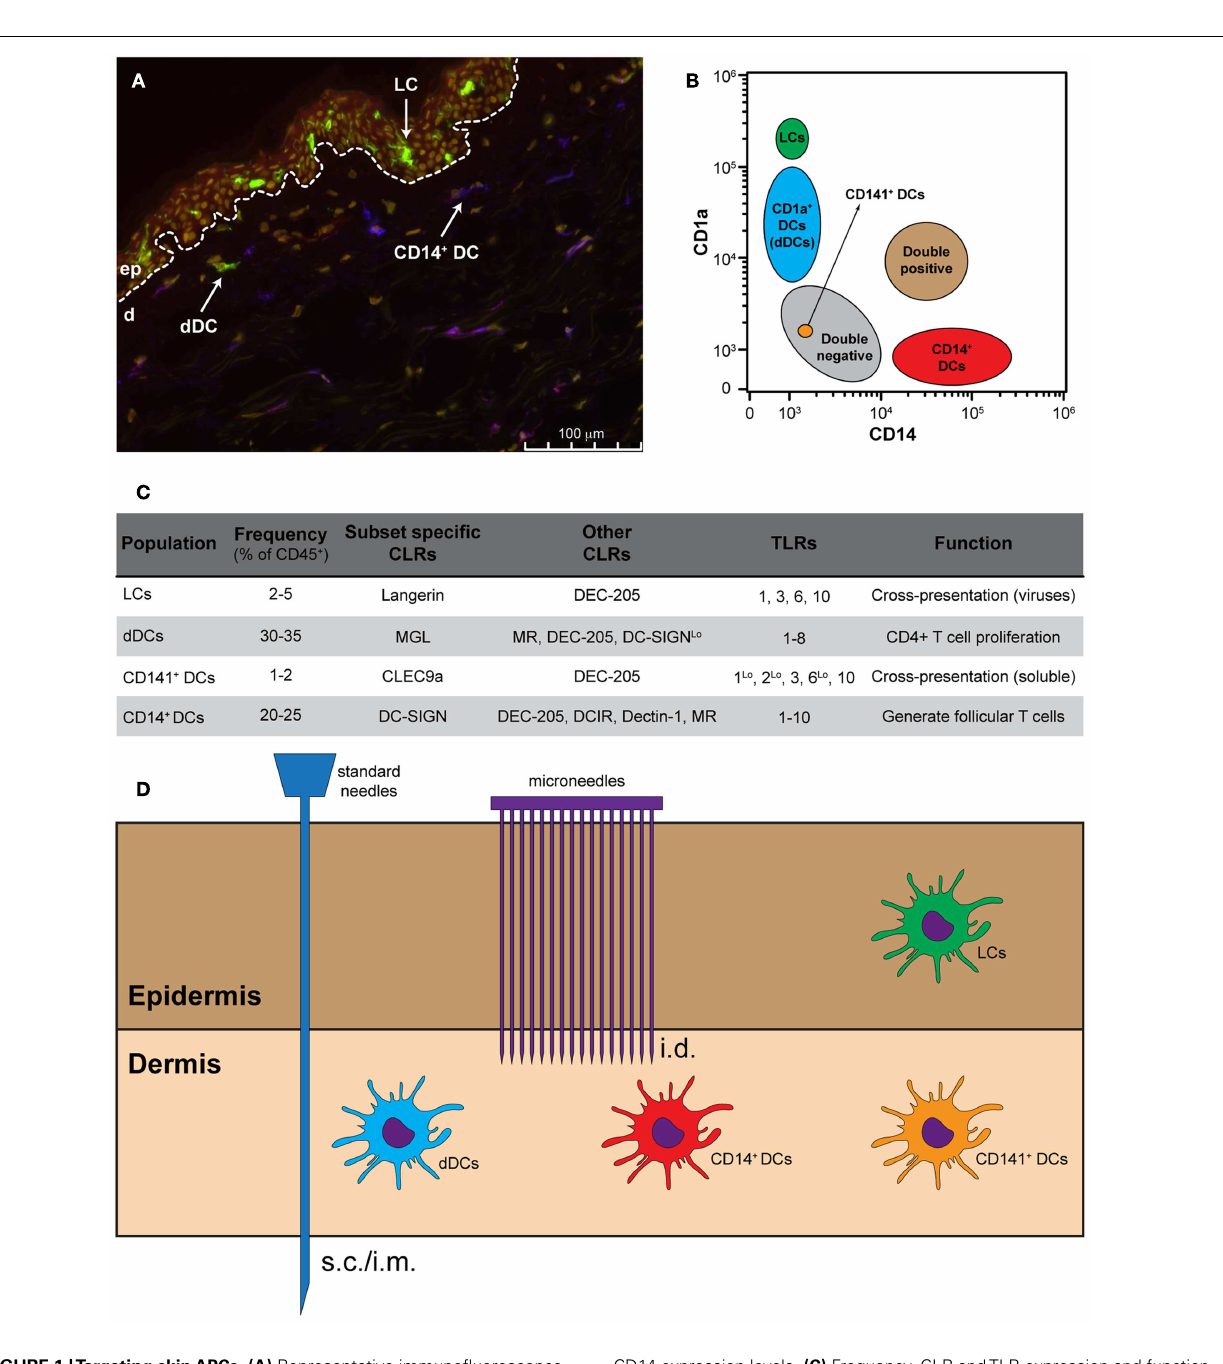
FIGURE 1 |Targeting skinAPCs . (A) Representative immunofluorescence staining of human skin using monoclonal antibodies against CD1a (green), CD14 (red), and DC-SIGN (blue). Nuclei are stained with the nuclear dye Hoechst (yellow). (B) Distribution of skin APCs according to their CD1a and